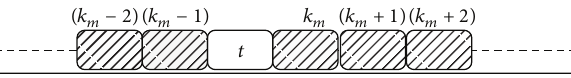
Figure 1: The position of maintenance